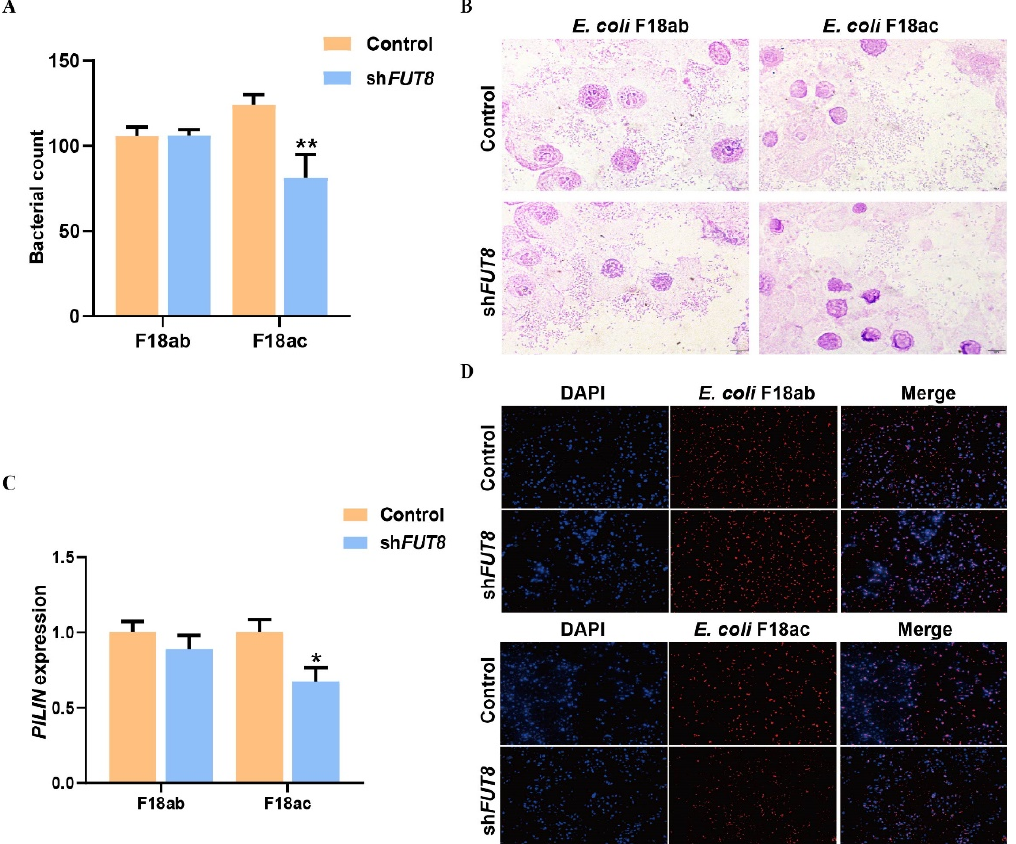
Figure 3. Analysis of the effect of FUT8 expression on E. coli adhesion. ( A ) Expression detection of E. coli F18 fimbriae gene ( PILIN ) via relative quantification in FUT8 -silenced IPEC-J2 cells. ( B ) Gram staining assay. An optical microscope (400×) was used to observe cells. ( C ) Colony count for F18ab and F18ac adhered shFUT8 cell. ( D ) Indirect immunofluorescence assay, blue fluorescence indicates nuclear staining via DAPI, and red fluorescence indicates staining with the anti- E. coli antibody. Cells were observed under a fluorescence microscope. * p < 0.05 and ** p < 0.01.